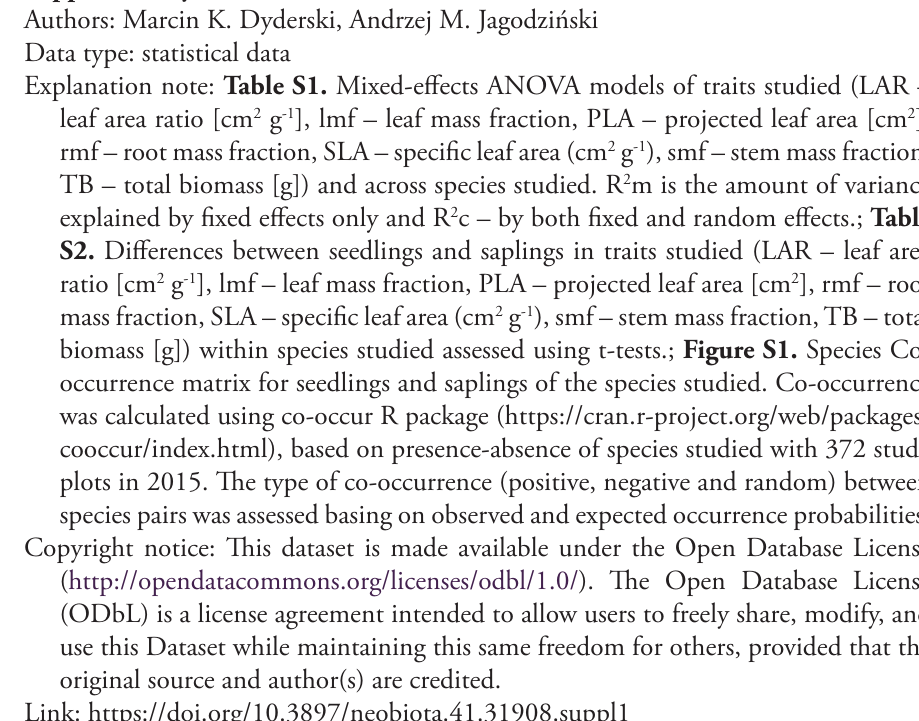
explained by fixed effects only and R 2 c – by both fixed and random effects.;